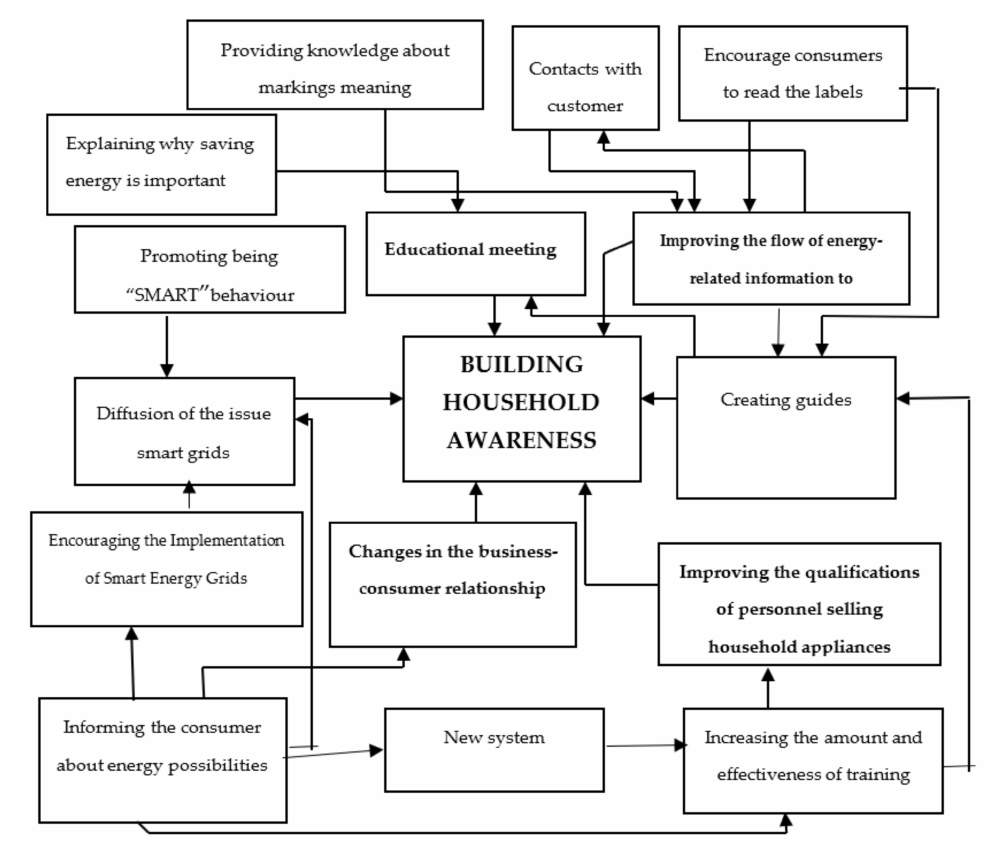
Figure 5. The interrelationship diagram for the problem: building household